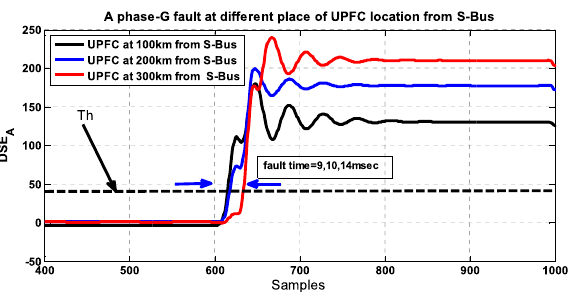
Fig. 11 A phase-G fault at different UPFC location from B-S